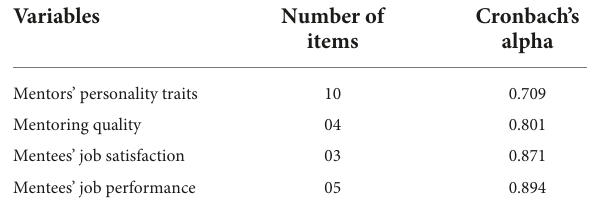
TABLE 2 Reliability analysis.